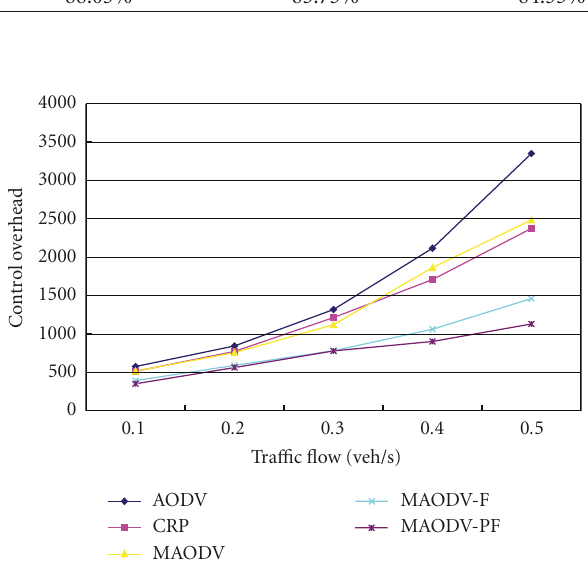
Figure 12: Control overhead for CRP, AODV, MAODV, MAODV-F, and MAODV-PF under di ff erent tra ffi c